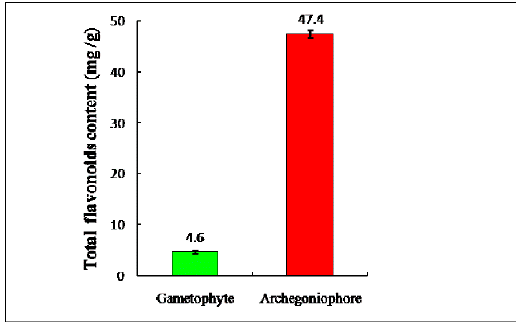
Figure 1. Total flavonoids contents of gametophyte and archegoniophore of M. polymorpha L . ( n = 3).